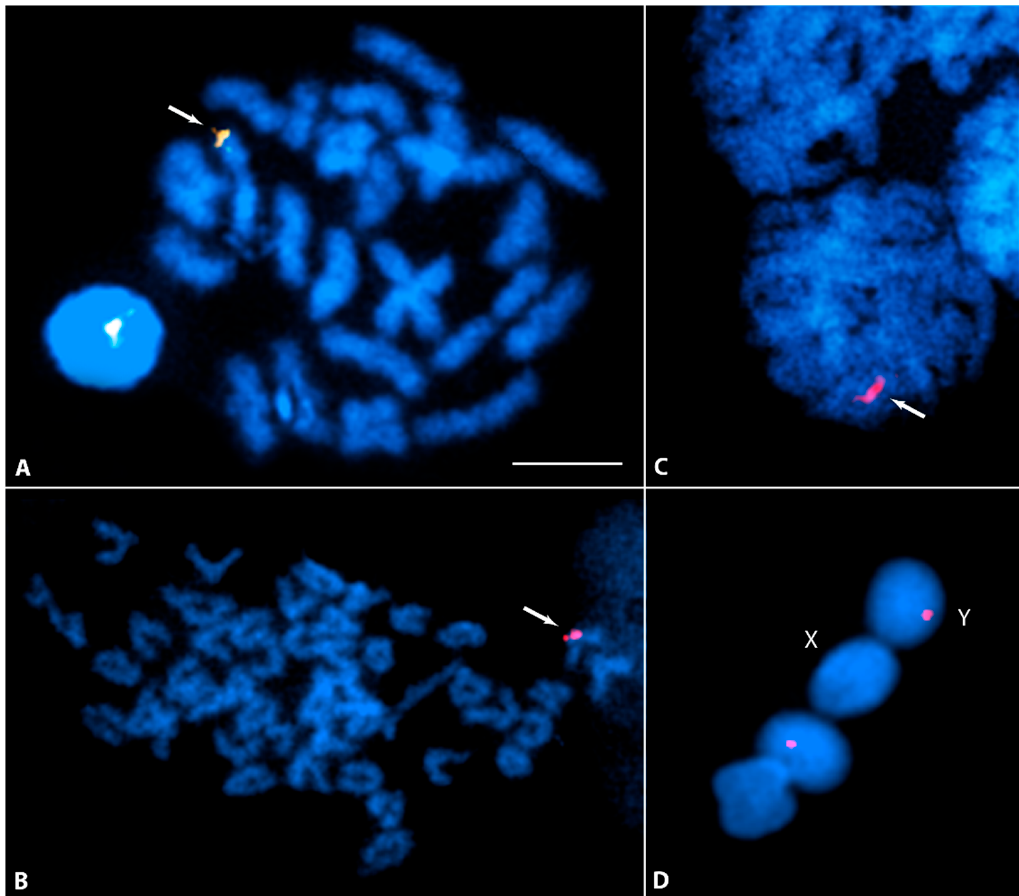
Figure 5. Indirect immunofluorescence showing 5-methylcytosine rich regions in metaphase I ( A ) and somatic male metaphase ( B ) of M. picta . The strong signal of hypermethylated sites marked by red fluorescence is specifically located around the centromeric region of the Y chromosome (arrows). Chromosomes are counterstained with DAPI. The strong fluorescence of the 5-MeC-region can be visualized (arrows) in pachytene ( C ), and Y bearing spermatid ( D ). Bar: 3 µm.